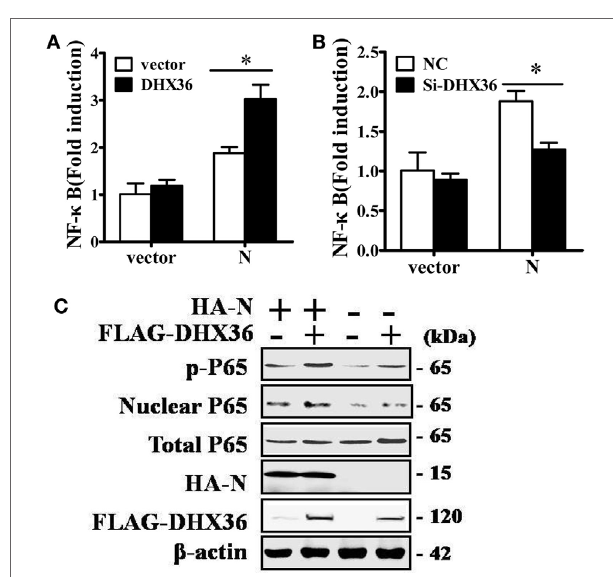
FigUre 6 | DExD/H-box helicase 36 (DHX36) is involved in N protein- induced NF- κ B activation. (a) MARC-145 cells were transfected with the N protein and/or DHX36 along with NF- κ B reporter plasmid and the pRL-TK plasmid. Cells were collected for dual-luciferase assay at 36 h post-transfection. (B) MARC-145 cells were transfected with either DHX36 small-interfering RNA (siRNA) or negative control siRNA. At 24 h post- transfection, cells were transfected with NF- κ B reporter plasmid and pRL-TK plasmid along with N protein. After a further 36 h, cells were collected and lysed for dual-luciferase assay. (c) HEK293T cells were co-transfected with expression vectors encoding FLAG-DHX36 and/or HA-N. Cytoplasmic and nuclear extracts were prepared at 28 h post-transfection and subjected to Western blot analysis with antibodies specific for P65 or